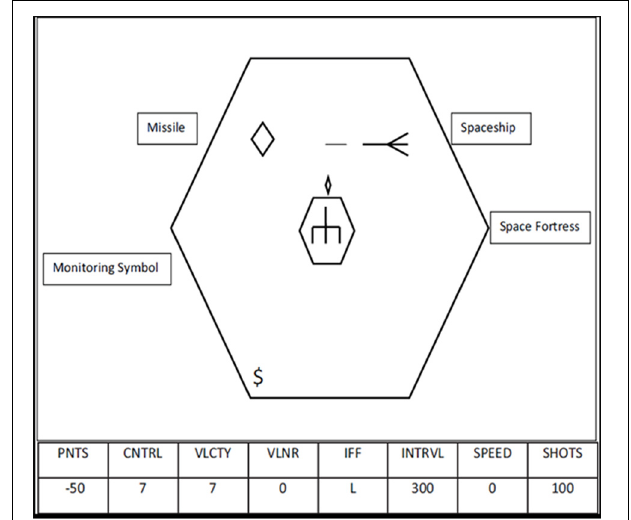
FIGURE 1 | Diagram of the Space Fortress game, figure originally published in Blumen et al.